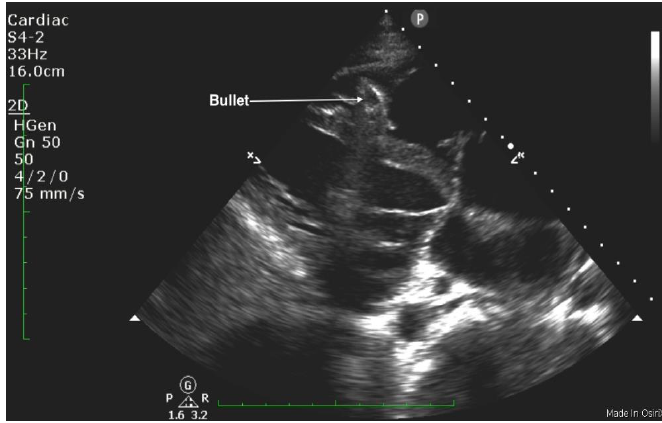
Figure 1. Parasternal long axis view demonstrating a bullet fragment within the right ventricle.